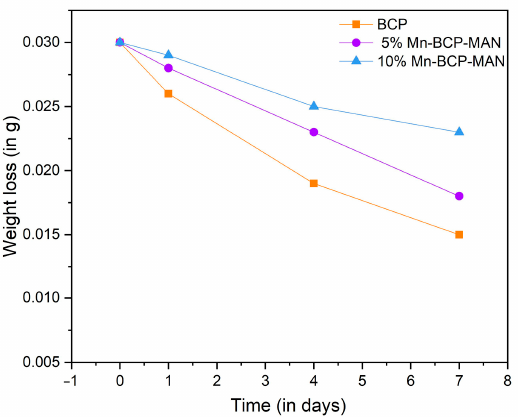
Figure 6. Degradation of the scaffolds for 1-week soaking period.